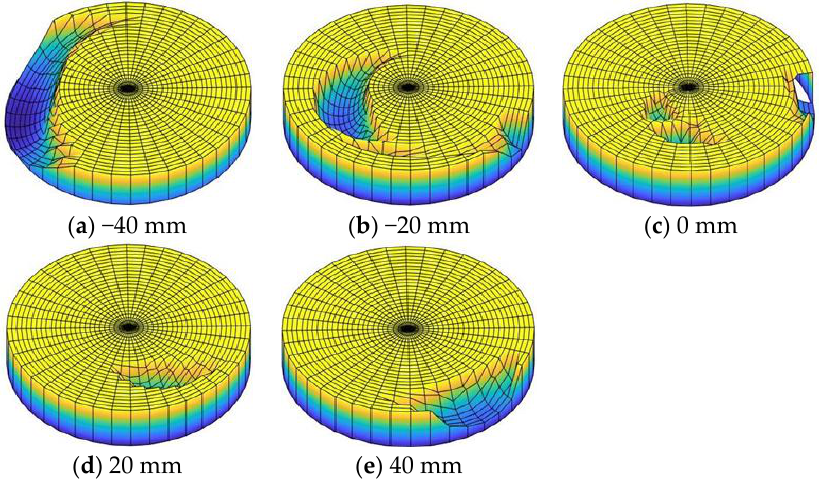
Figure 31. Scratch damage morphology on the workpiece surface with different magnetic field eccentricities.